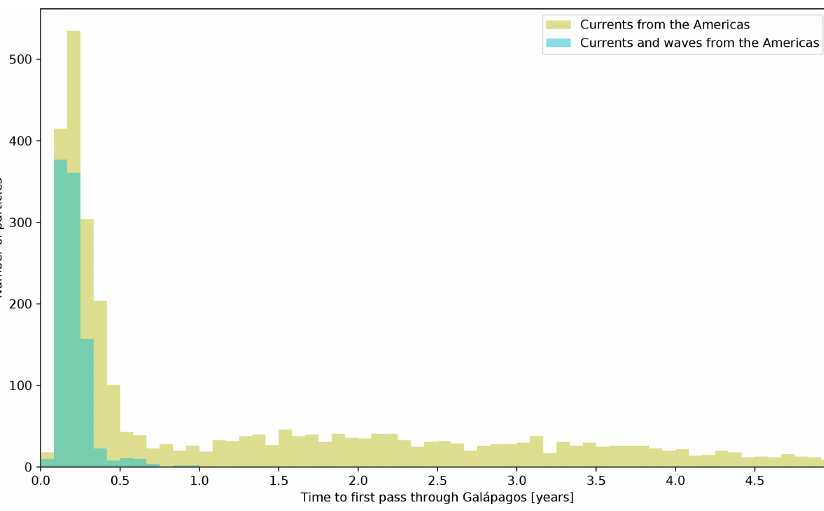
Figure 6. Histogram of the time in days required for particles to travel from the west coast of America to the Galápagos region for particles carried by currents only (yellow bars) and for particles carried by the currents and waves (blue bars). Most particles arrive within 3–4months, although there is a significant tail all the way to 5 years for the simulation with currents only.